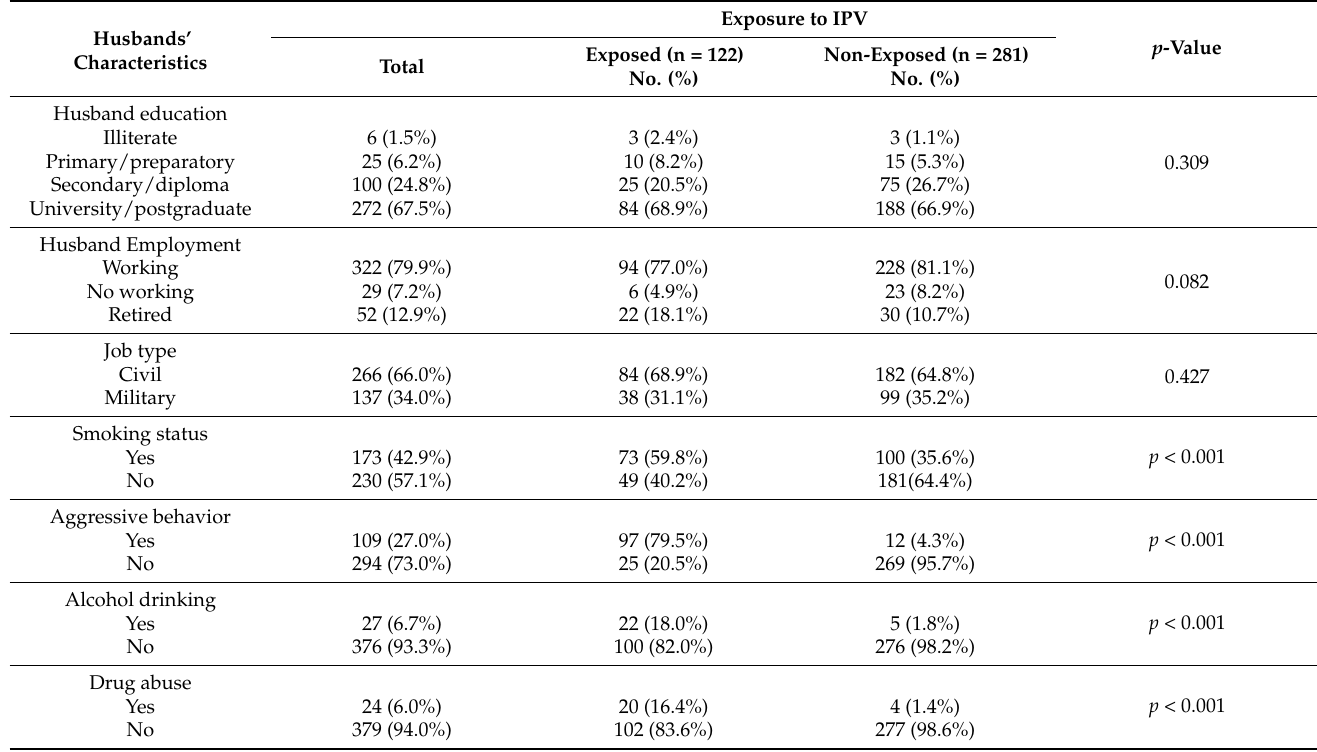
Table 3. Relationship between IPV and characteristics of husbands of women attending different primary health centers in Aljouf region, Saudi Arabia.